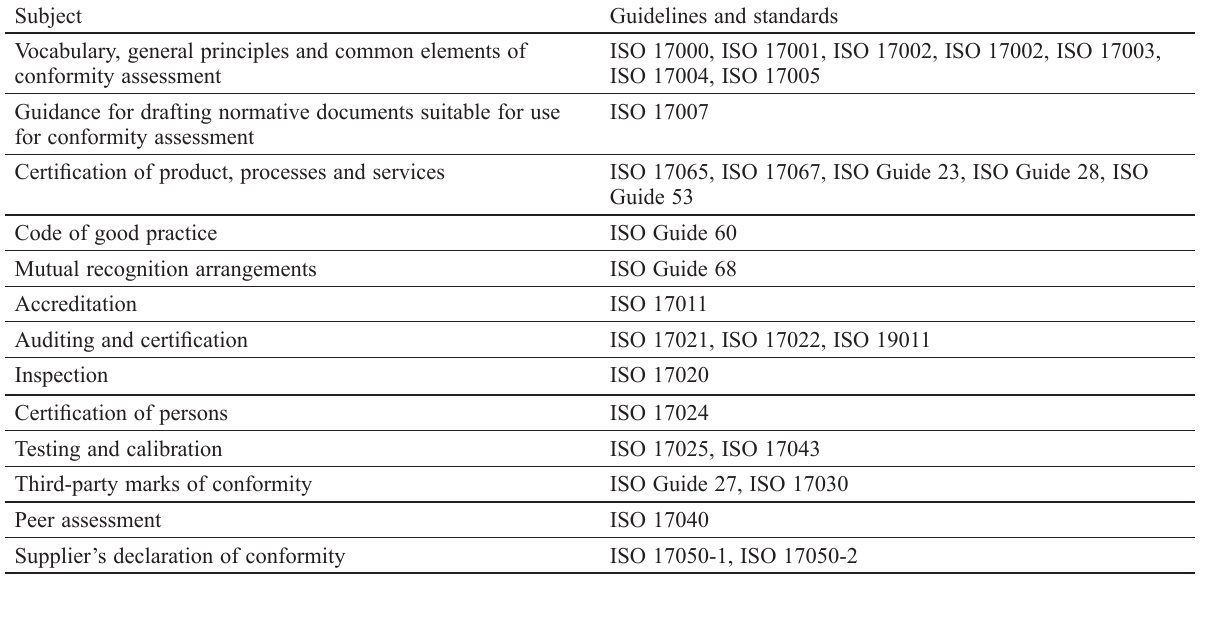
Table 4. List of international conformity assessment guidelines and standards